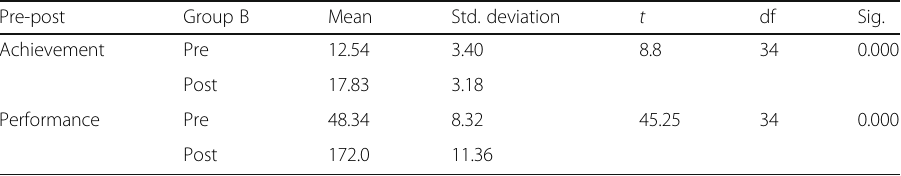
Table 3 Results of descriptive statistics and paired samples t test for group B ( n = 35) Pre-post Group B Mean Std. deviation t df Sig. Achievement Pre 12.54 3.40 8.8 0.000 Post 17.83 3.18 Performance Pre 48.34 8.32 45.25 0.000 Post 172.0 11.36 p <